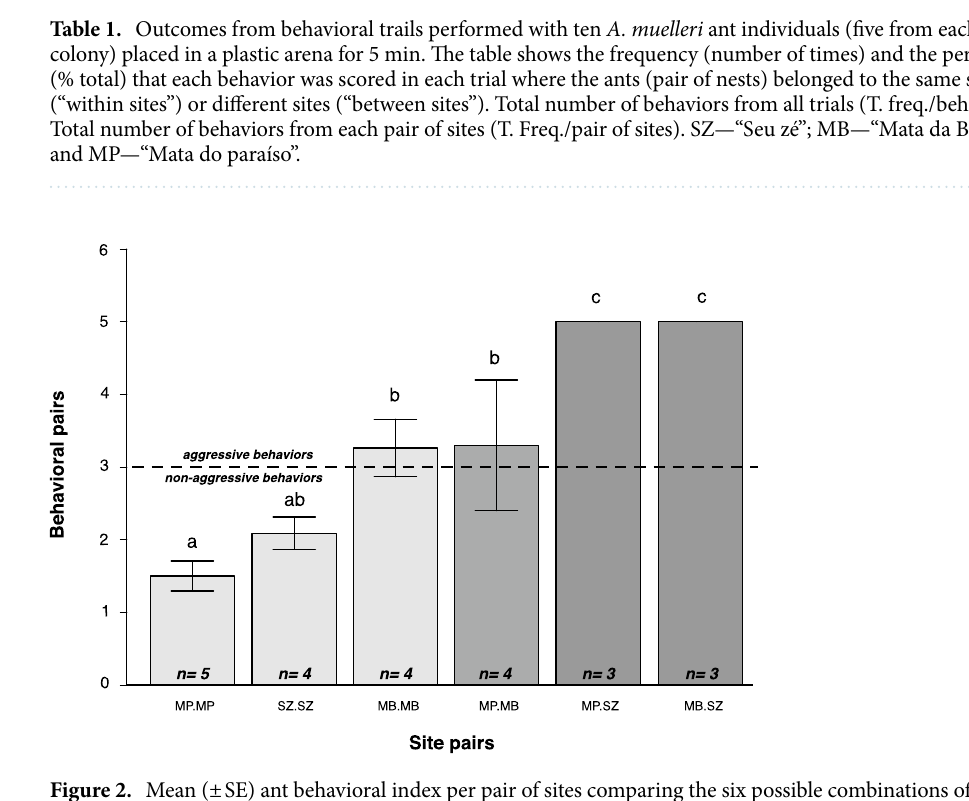
Figure 2. Mean (± SE) ant behavioral index per pair of sites comparing the six possible combinations of sites. Within sites—MP versus MP; SZ versus SZ; MB versus MB and between sites: MP versus MB; MP versus SZ; MB versus SZ. SZ—“Seu zé”; MB—“Mata da Biologia” and MP—“Mata do paraíso. Inside each bar is the number of trials within and between the three sampling